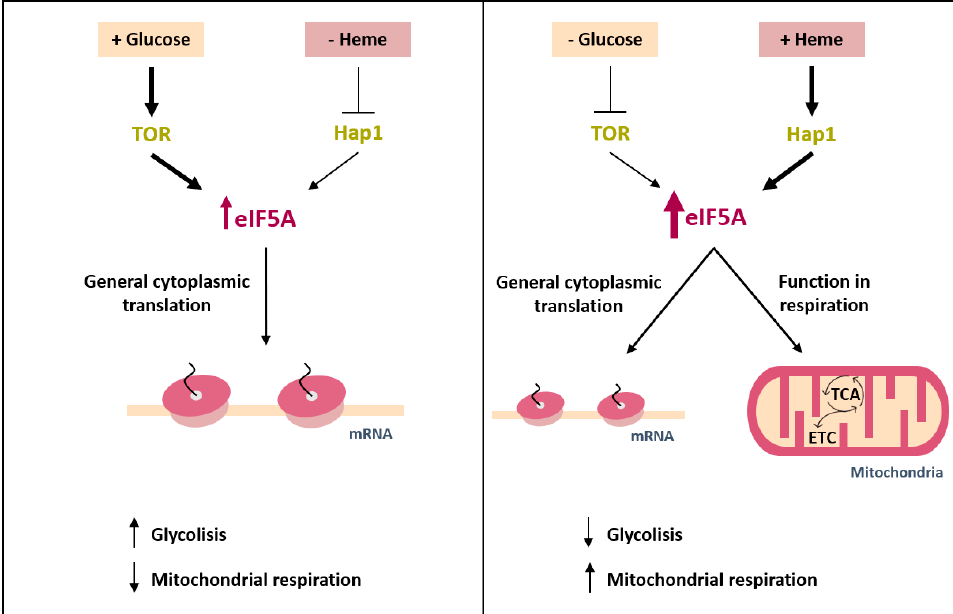
Figure 7. Model of regulation of the translation elongation factor eIF5A expression by nutrient availability through different signalling pathways. Under nutrient availability conditions, glucose signalling via TOR up-regulates eIF5A expression to facilitate cytoplasmic translation, and glycolysis predominates over mitochondrial respiration. Under low glucose and/or non-fermentative carbon sources, TOR positive eIF5A regulation is inhibited, but eIF5A expression is up-regulated by the increase in heme levels and subsequent Hap1 activation. In these conditions, eIF5A promotes, additionally to cytoplasmic translation, not-well known functions in mitochondrial respiration.